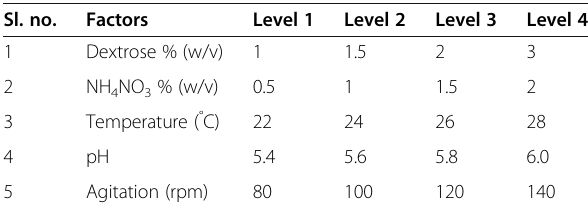
Table 1 Selected process parameters and respective levels in the experimental design Sl. no.